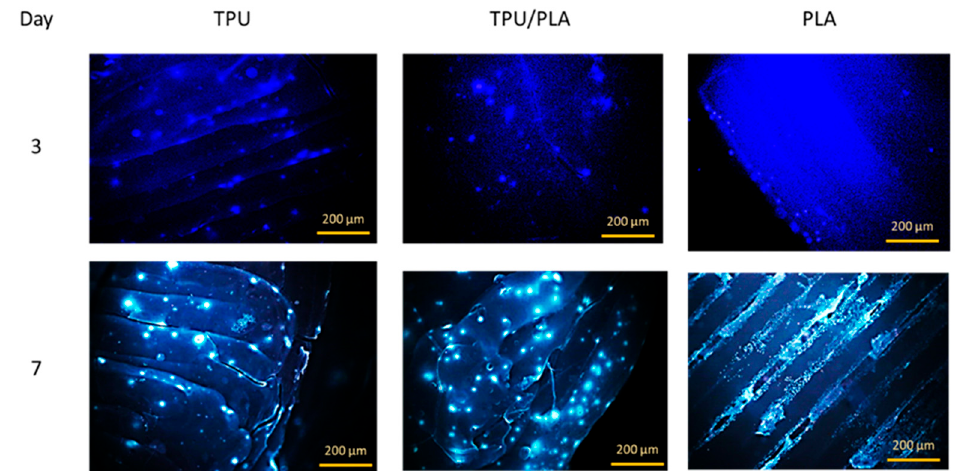
Figure 5. Direct cell attachment assay using Hoechst 33342. The fluorescence image shows that cells had attached to all three scaffold surfaces on day 3. On day 7, more cells were visible, especially between the PLA filaments. The cells appeared slightly out of focus as they were inside the scaffold folds. Scale bar: 200 µm.